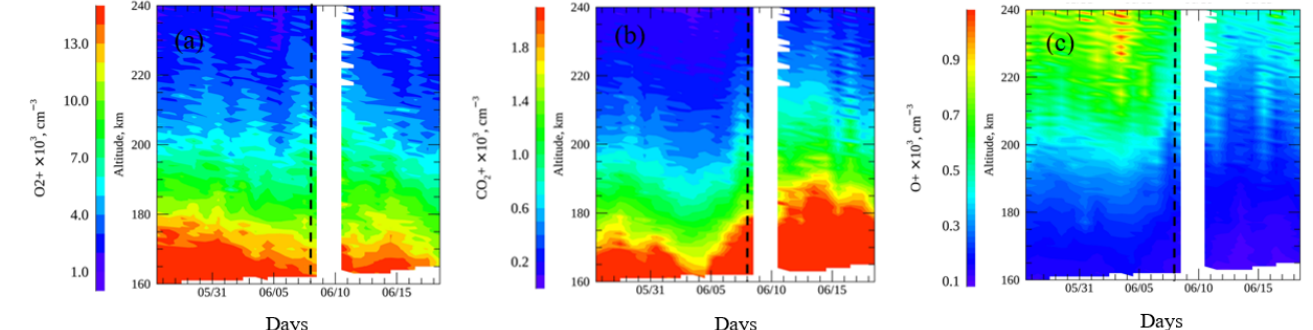
Figure 3. Ion species and electrons density distribution 27 May to 17 June 2018, at altitudes of 160–240 km and SZAs of 50–85°: ( a ) O 2+ , ( b ) CO 2+ , and ( c ) O + . The vertical black line on 8 June 2018 indicates the storm onset. The blank regions represent missing NGIMS data from all of 9 June and most of 10 June.